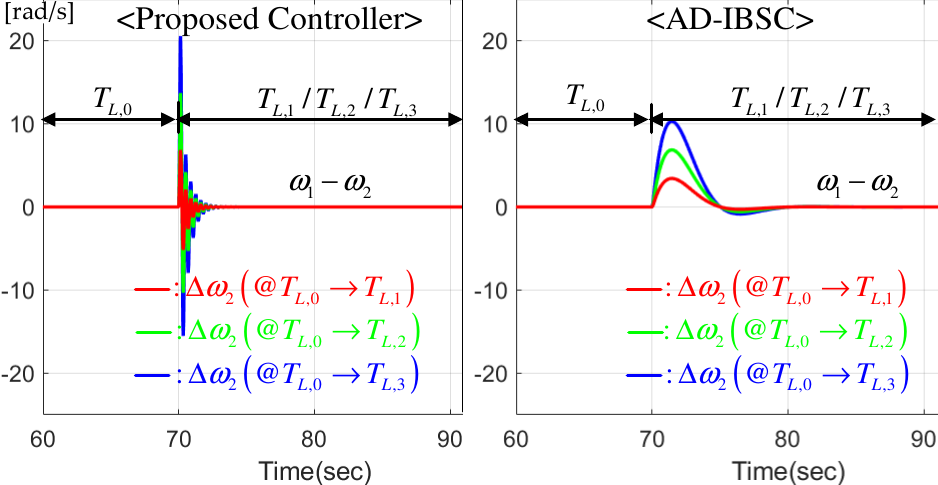
Figure 9. Speed synchronization error comparison (slave motor) for different load